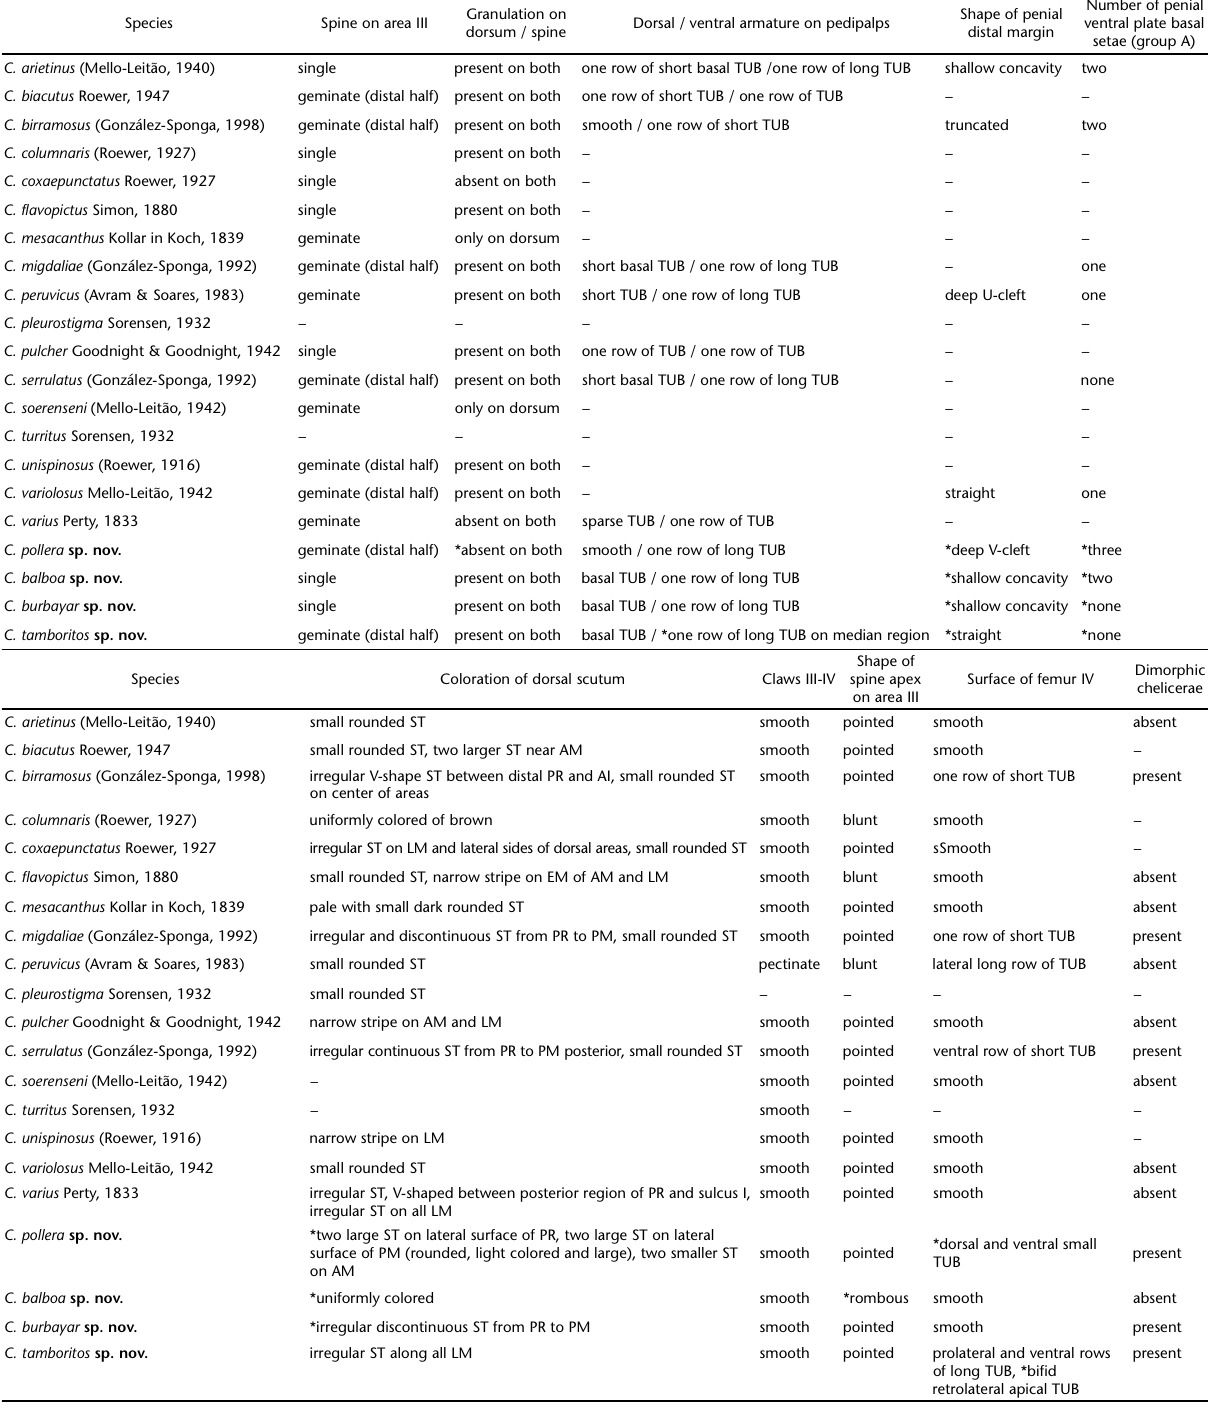
Table 1. Diagnostic characters for the 21 species of Cosmetus . Abbreviations used (TUB) tubercles; (AM) anterior margin; (LM) lateral margin; (EM) external margin; (PM) posterior margin; (PR) prosoma; (AI-IV) areas I-IV; (ST) spots. Asterisk (*) indicate the diagnostic features of new